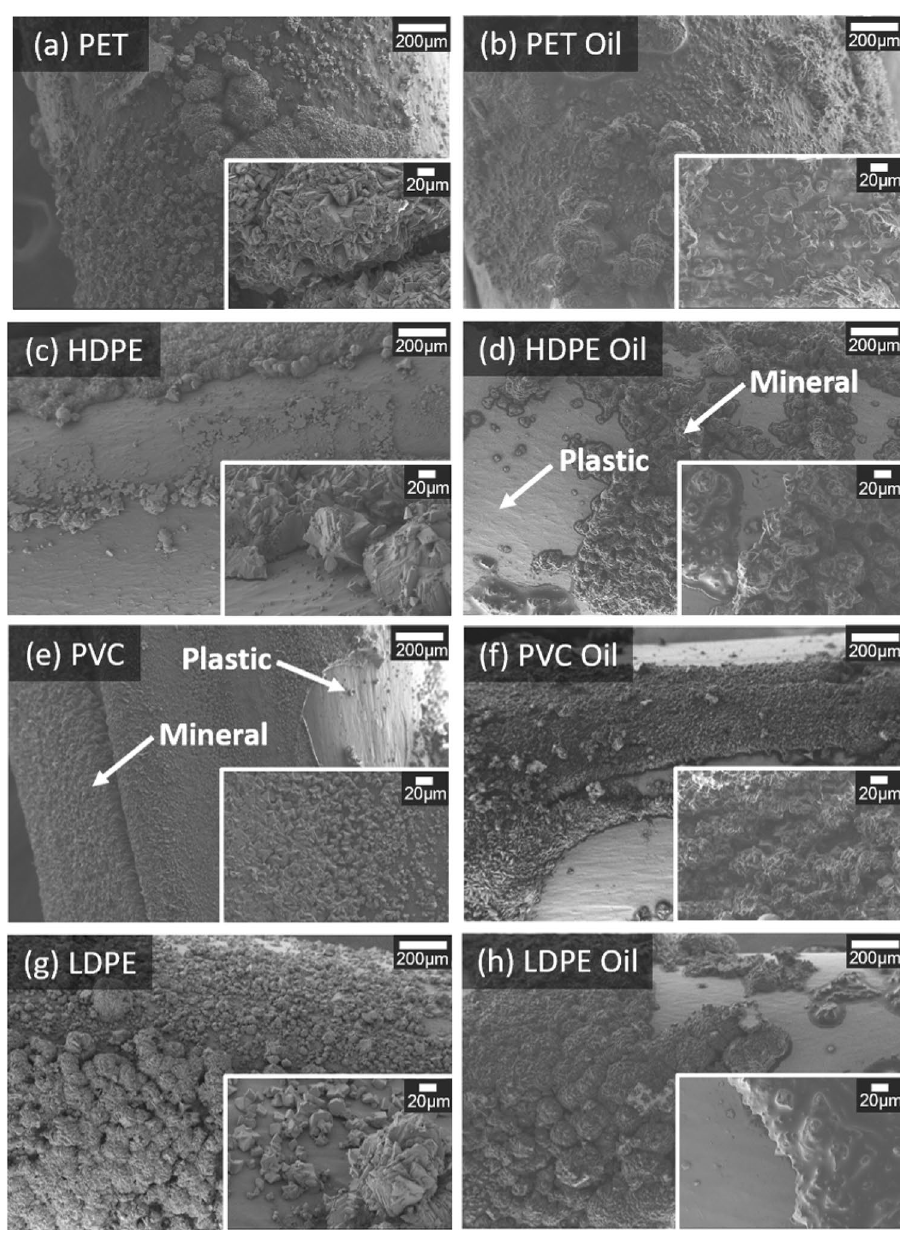
Figure 4. Scanning electron micrographs of biomineralized plastic types with ( a,c,e,g ) and without ( b,d,f,h ) the addition of oil at magnifications of 150x and inset images at magnification of